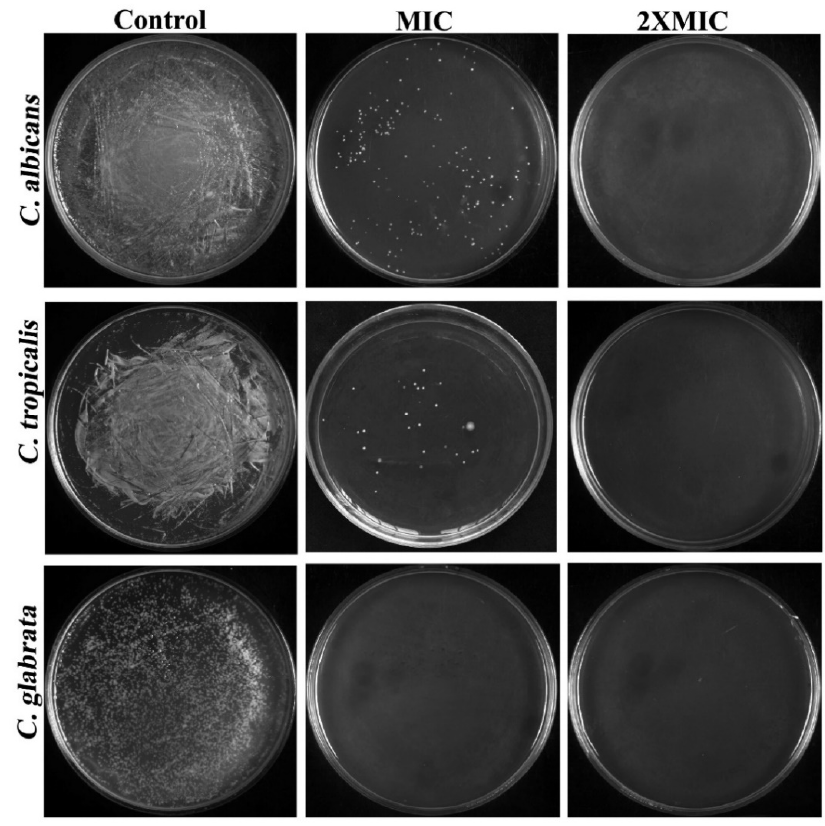
Figure 2. Determination of CTAC MFC against C. albicans , C. tropicalis , and C. glabrata through spread plate method.